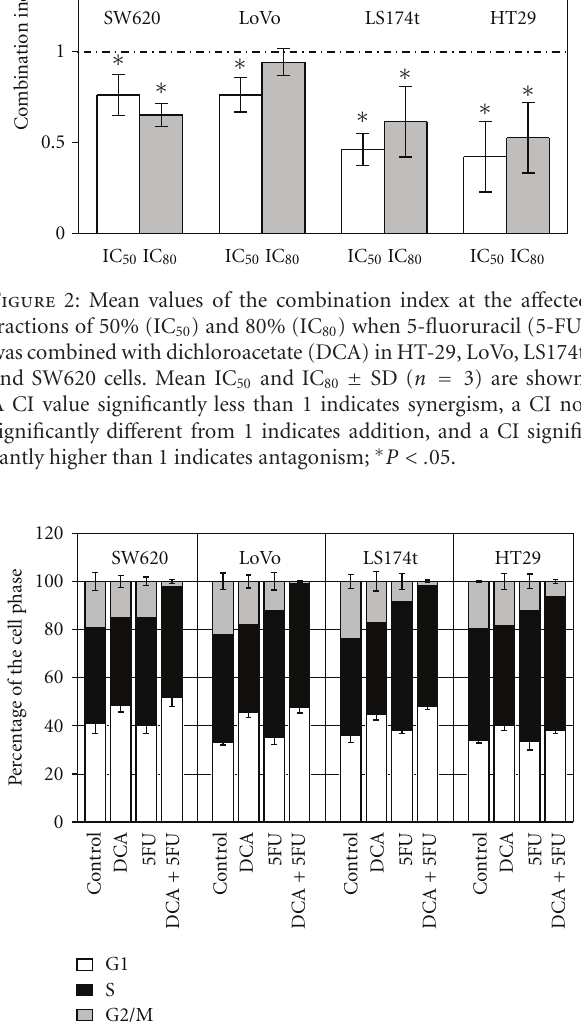
Figure 3: Changes in cell cycle progression in SW620, LoVo, LS174t, and HT29 cells after 48-hour treatment with 5-fluoruracil (5-FU) and dichloroacetate (DCA) applied alone or in combina- tion. Each bar represents the mean ± SD ( n = 3). The data obtained from FACS were analyzed using SPSS13.0; ∗ P < . 05.